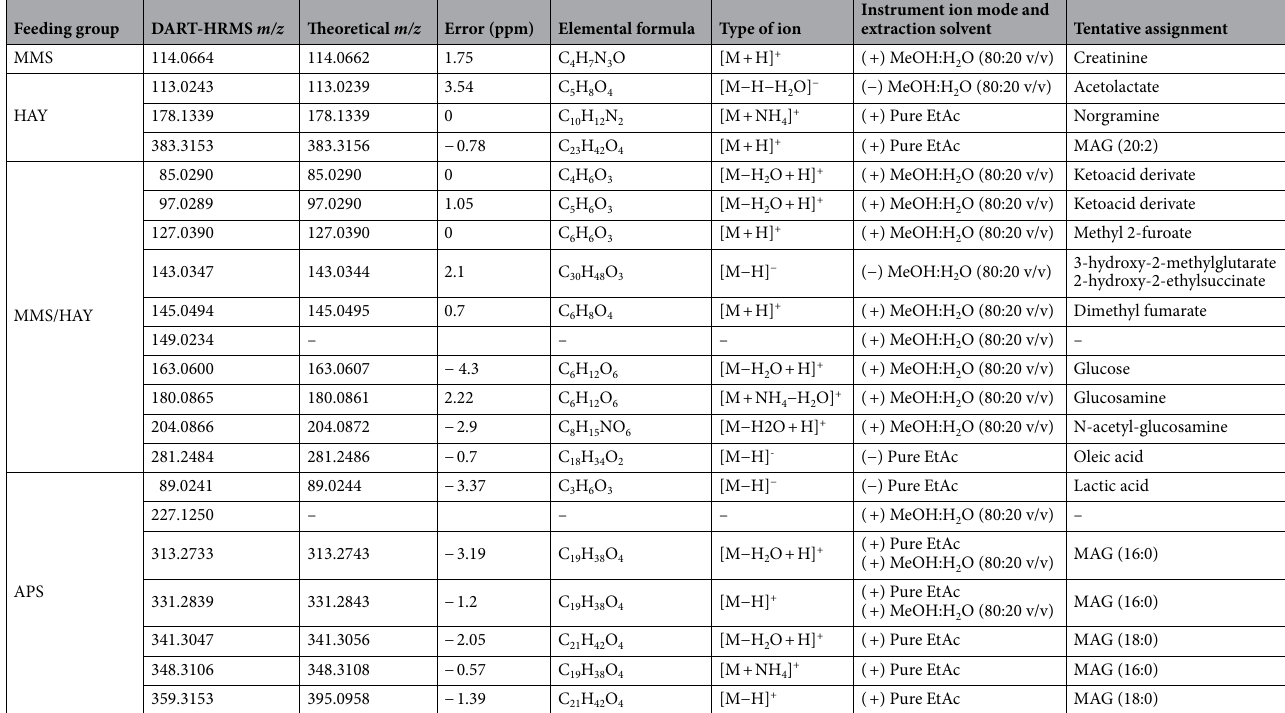
Table 3. Discriminative (+ /−) DART-HRMS metabolites detected in milk samples according to the dietary feeding groups. MMS , mix maize/crop silages; HAY , permanent meadow and lucerne hays; APS , Alpine pasture; MAG , monoacylglycerol.